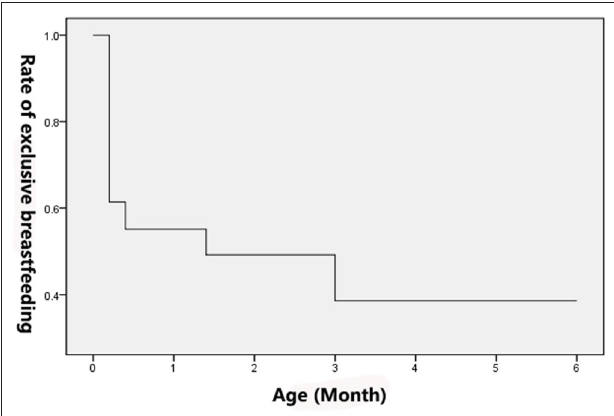
FIGURE 2 | Curve of exclusive breastfeeding